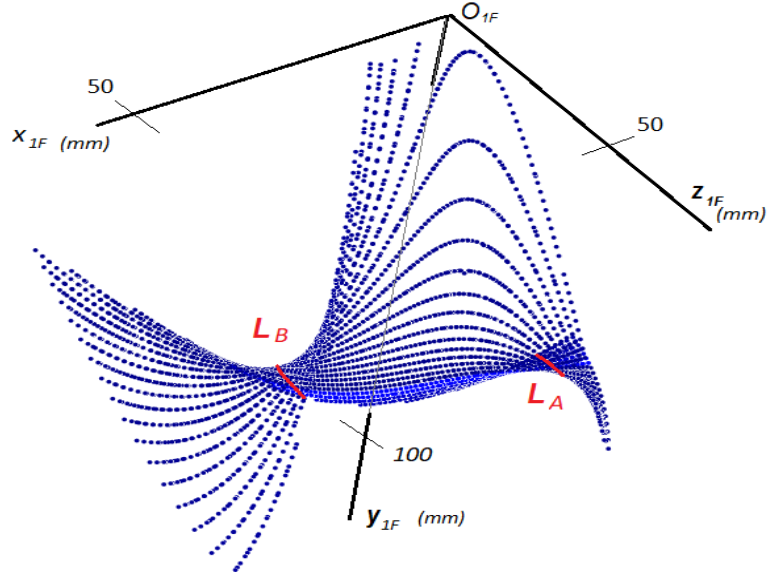
Figure 5. Contact lines with the L A and L B curves on the worm surface Σ 1 . For the cylindrical arched worm, L A and L B curves can be found having points to cause the singularity on the gear tooth surface. To avoid undercutting on the gear surface Σ 2 , it is sufficient to delimit the worm surface Σ 1 during design by eliminating the L A and L B curves.